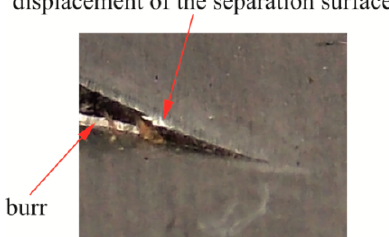
Figure 18. Zoom area (in Figure 17) near the separation of the material of the hook deflection. Figure 17. Burr ( b h ) on the edge of the sheet for hook cuts out with a clearance of 15%.